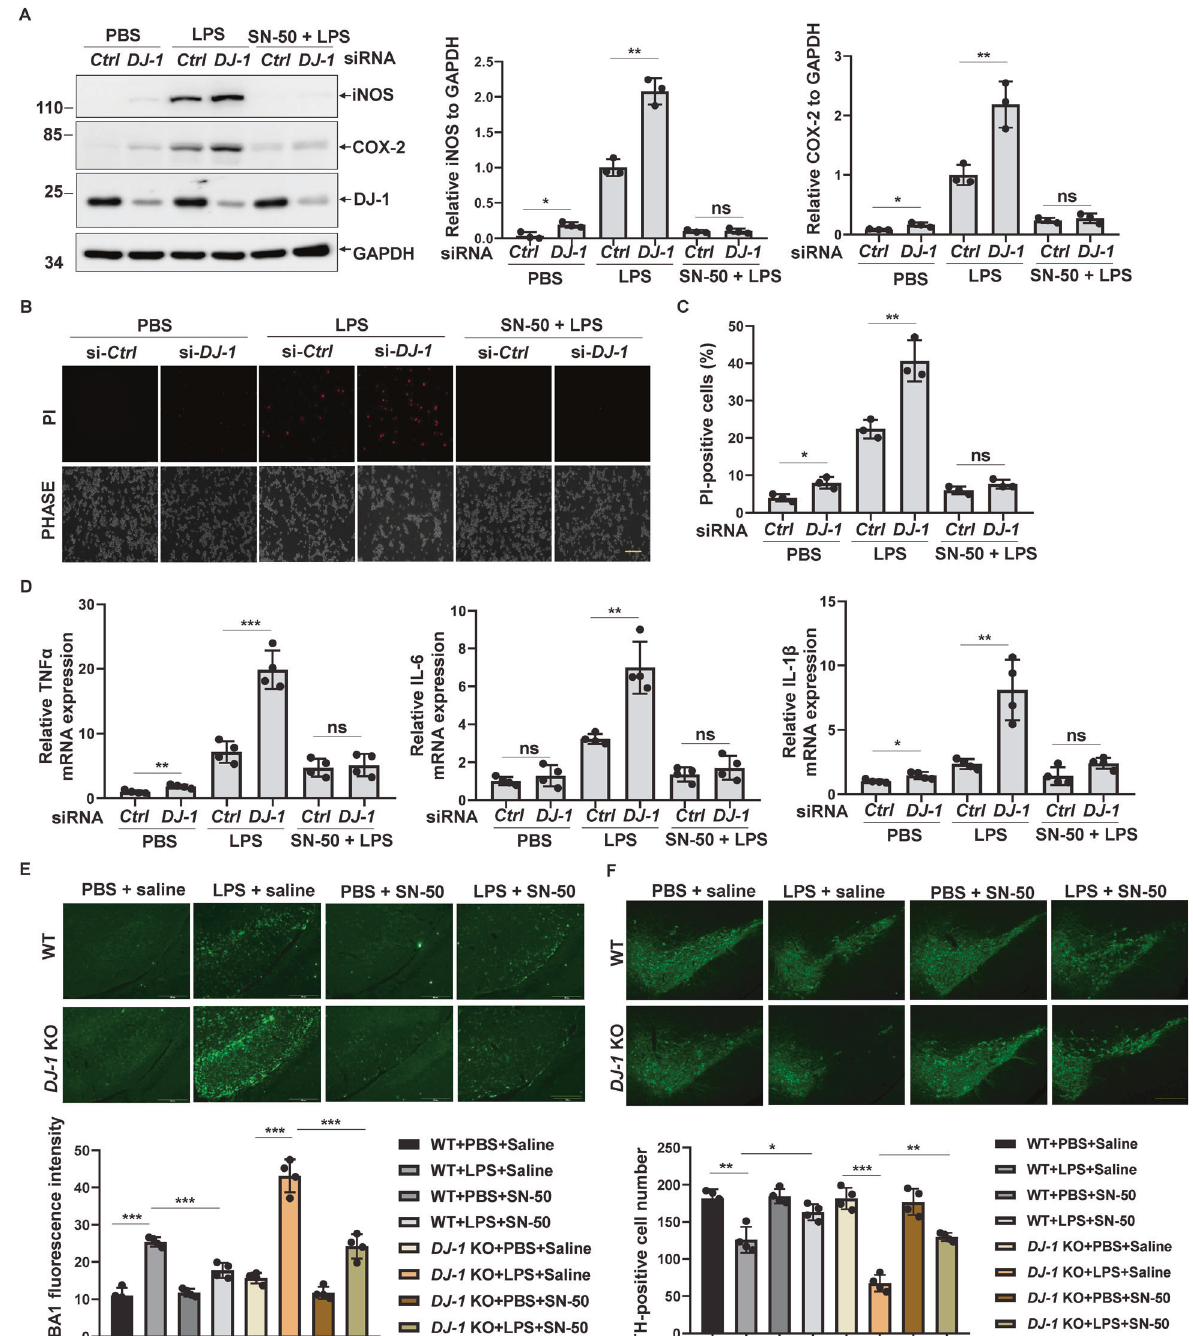
Fig. 6 DJ-1 de fi ciency increases NF- κ B-dependent microglial neurotoxicity. A BV2 cells transfected with si- Ctrl or si- DJ-1 for 48 h were treated with PBS or LPS (100 ng/ml) for 24 h followed by pretreated with SN-50 (20 μ M) for 1 h as indicated. After treatment, cell lysates were subjected to immunoblotting. The relative band intensity of iNOS or COX-2 to that of GAPDH was quanti fi ed. n = 3. B N2a cells cultured in conditioned media collected from BV2 cells with the indicated treatment for 24 h were then stained with PI and visualized with an inverted microscope. Scale bar, 50 µm. C The percentage of PI-positive cells in ( B ) was analyzed. n = 3. D Primary microglia transfected with si- Ctrl or si- DJ-1 for 48 h were treated with PBS or LPS (100 ng/ml) for 6 h followed by pretreated with SN-50 (20 μ M) for 1 h as indicated, then the samples were subjected to qRT-PCR. * P < 0.05, n = 4. E , F DJ-1 − / − and the littermate wild-type controls were microinfused with PBS or LPS for 14 days followed by saline or SN-50 into the SN as indicated, and then the immunohistochemical staining was conducted using ( E ) anti-IBA1 antibody or ( F ) anti-TH antibody. The fl uorescence intensity of IBA1 ( E ) and the number of TH-positive neurons ( F ) in SN of each slice were quanti fi ed. n = 4.